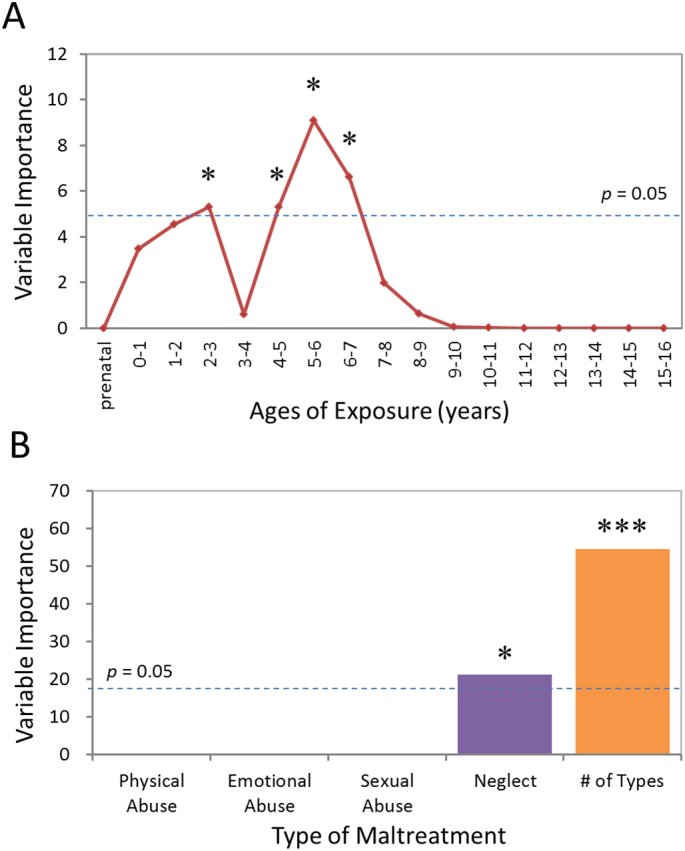
(A) Maximal sensitivity by age of exposure (maximal importance of age of exposure, regardless of type) in RAD. Results of a random forest regression with conditional trees indicated the importance of exposure to early maltreatment from birth to 16 years of age on the GM eigenvariates for the left visual cortex. Importance is indicated by degradation in fit, as indicated by the increase in mean square error (MSE), following effective elimination of each age from the model by permutation. (B) Maximal sensitivity by type and number of maltreatments (maximal importance of type and number of maltreatments, regardless of age) in RAD. * p < 0.05; *** p < 0.001 (FDR-corrected for multiple comparisons).